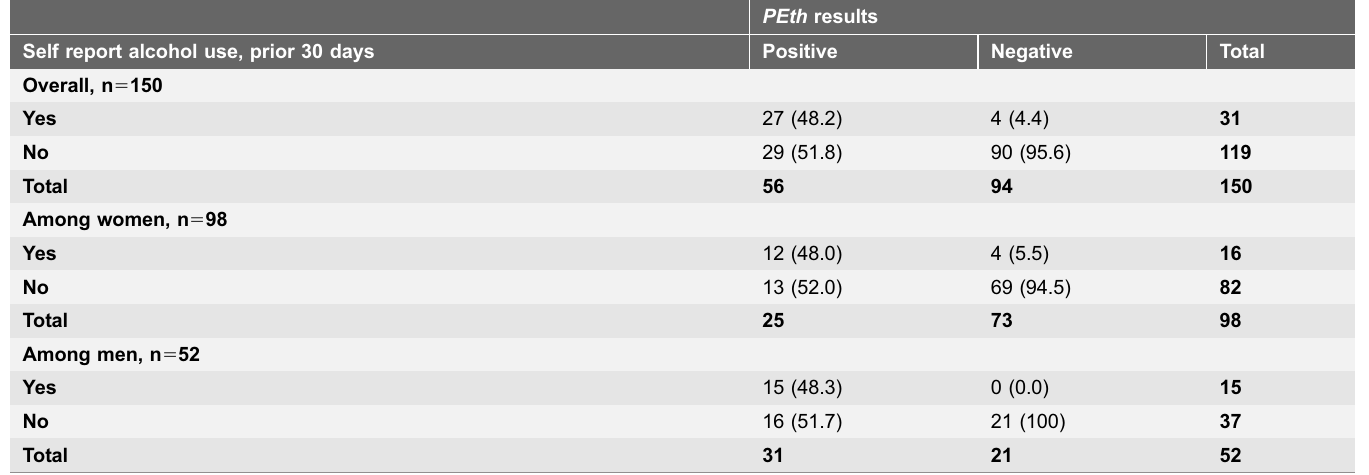
Table 2. Sensitivity for self reported alcohol use, overall and by sex.